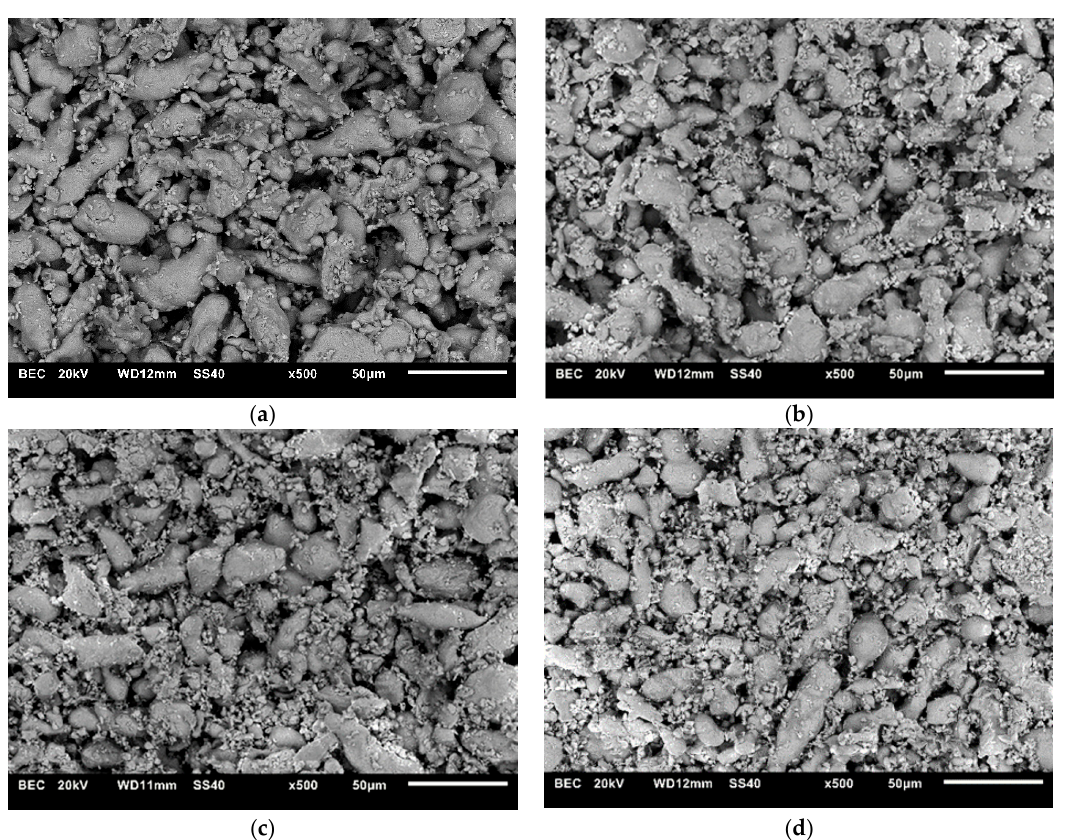
Figure 2. SEM images of powders: ( a ) steel + 5% ZrB 2 , ( b ) steel + 10% ZrB 2 , ( c ) steel + 15% ZrB 2 and ( d ) steel + 20% ZrB 2 .